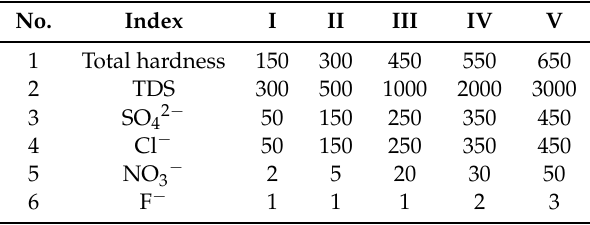
Table 4. Class threshold values for groundwater quality evaluation